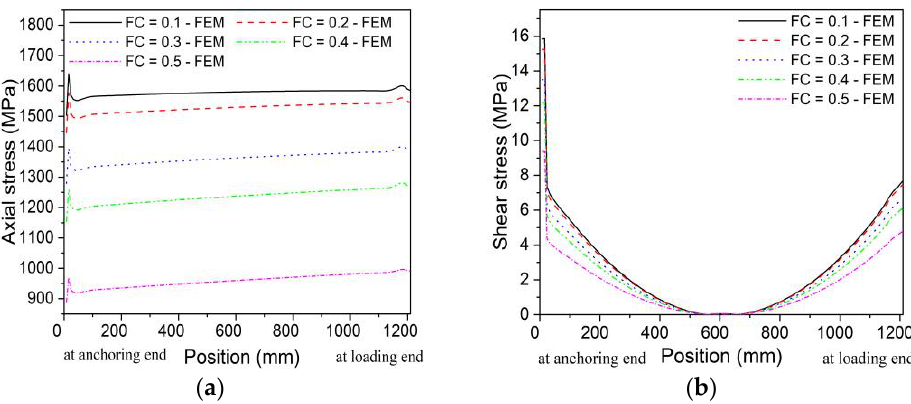
Figure 18. Effect of friction coefficient on the stress distribution of CFRP tendons: ( a ) axial stress; ( b ) shear stress. ( b ) shear